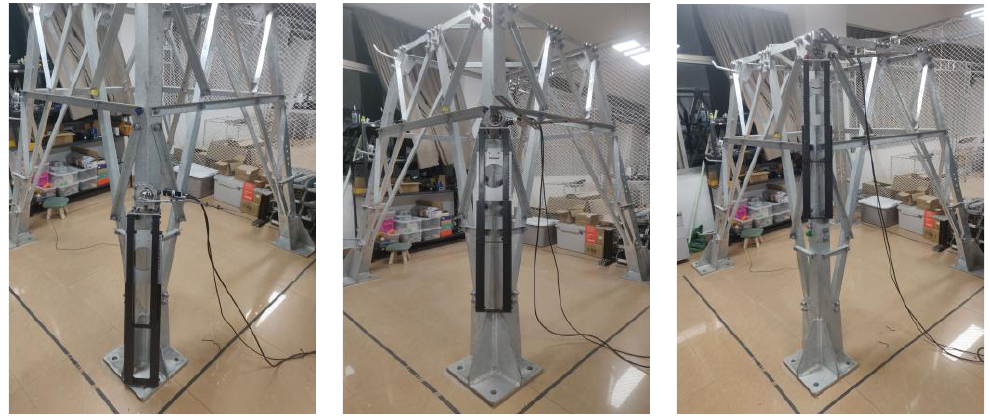
Figure 15. Acquisition of image information.